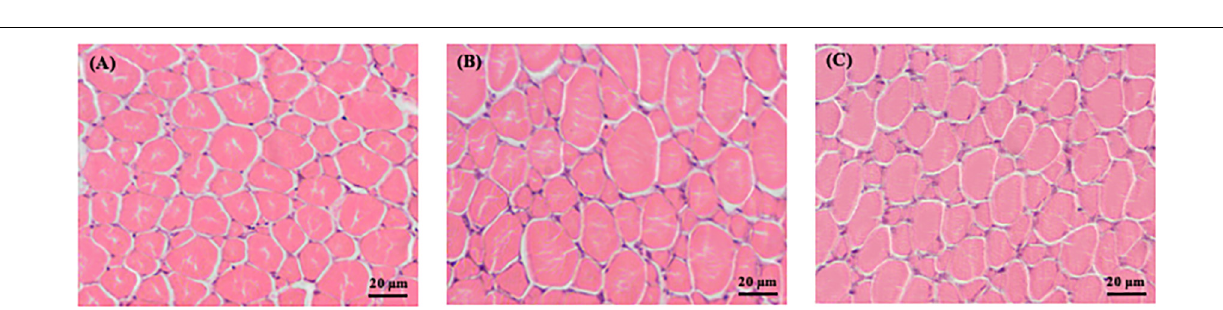
displayed a higher number of muscle fibers than the CTRL fed fish, but these differences were only statistically significant in the former [1.2-fold higher than the CTRL ( P = 0.046)].